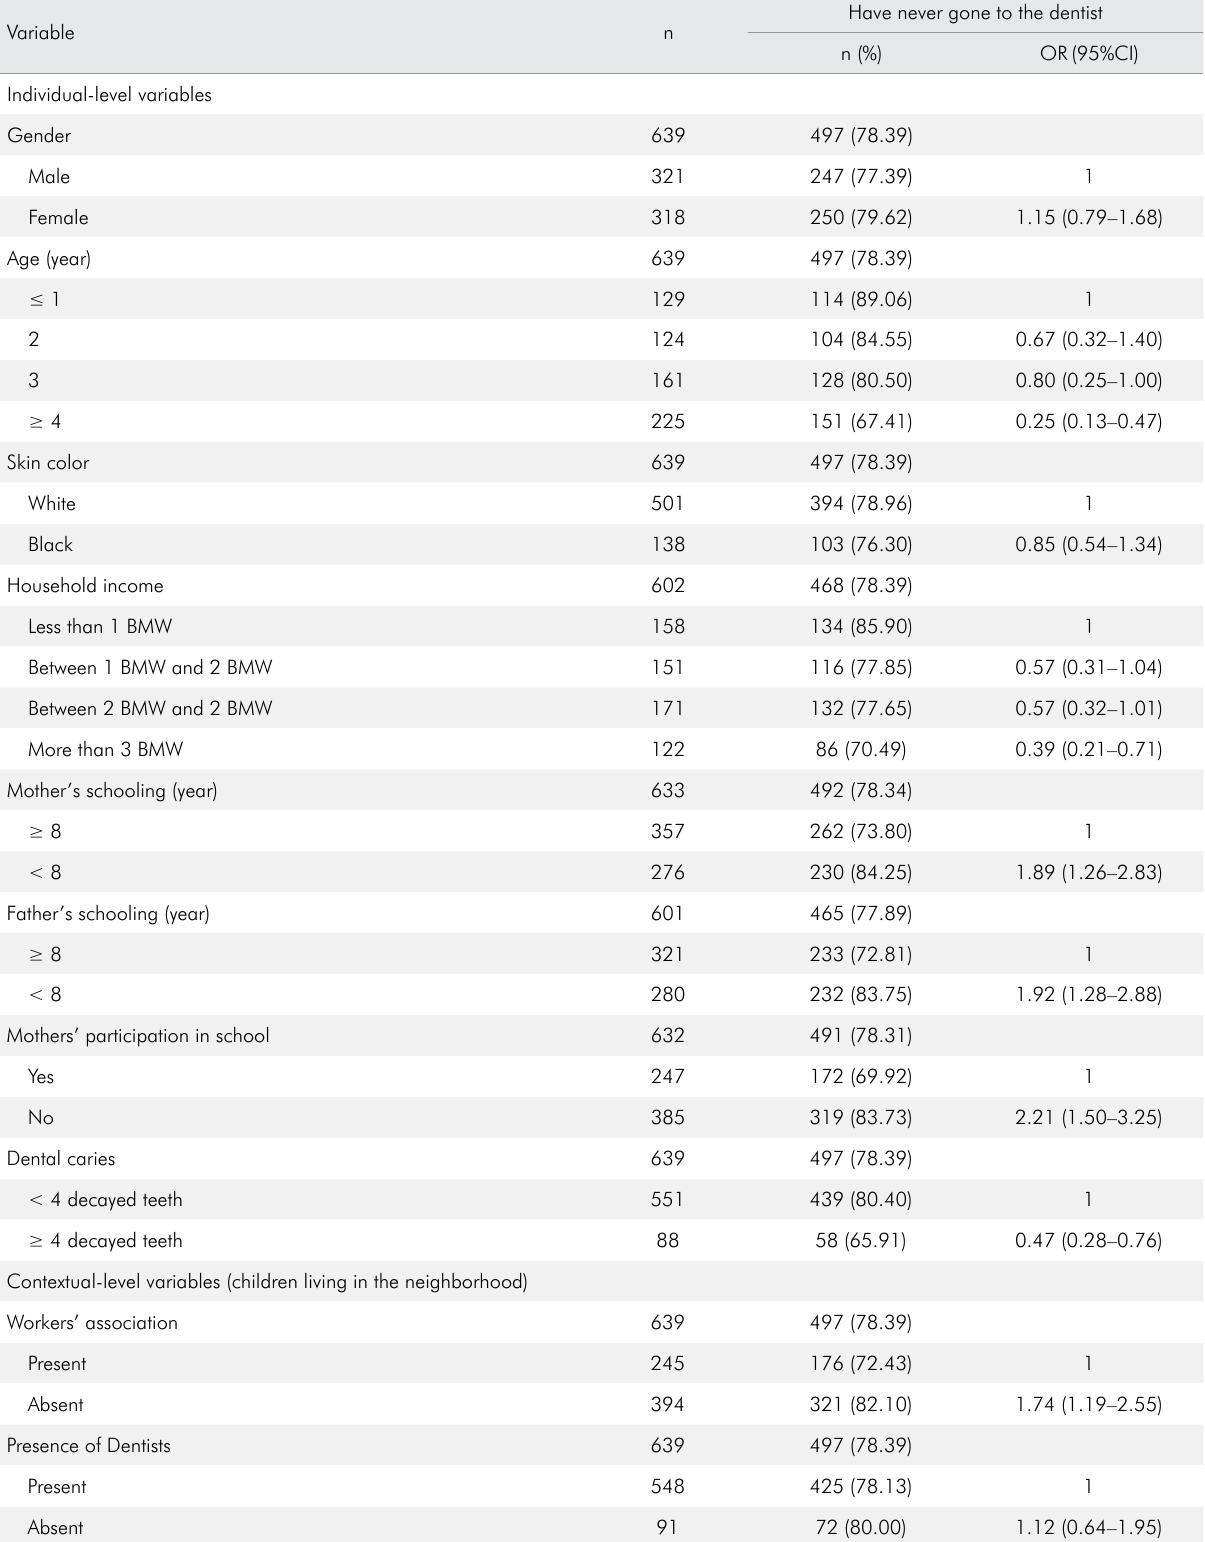
Table 2. Unadjusted assessment of the association of dental health care use among preschool children with individual and contextual-level